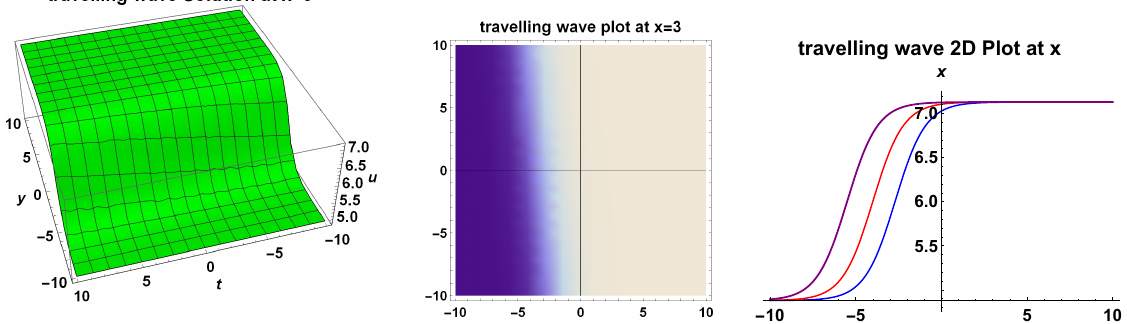
Figure 27. Tavelling wave profile depiction of nontrivial solution (113) at x = 3.